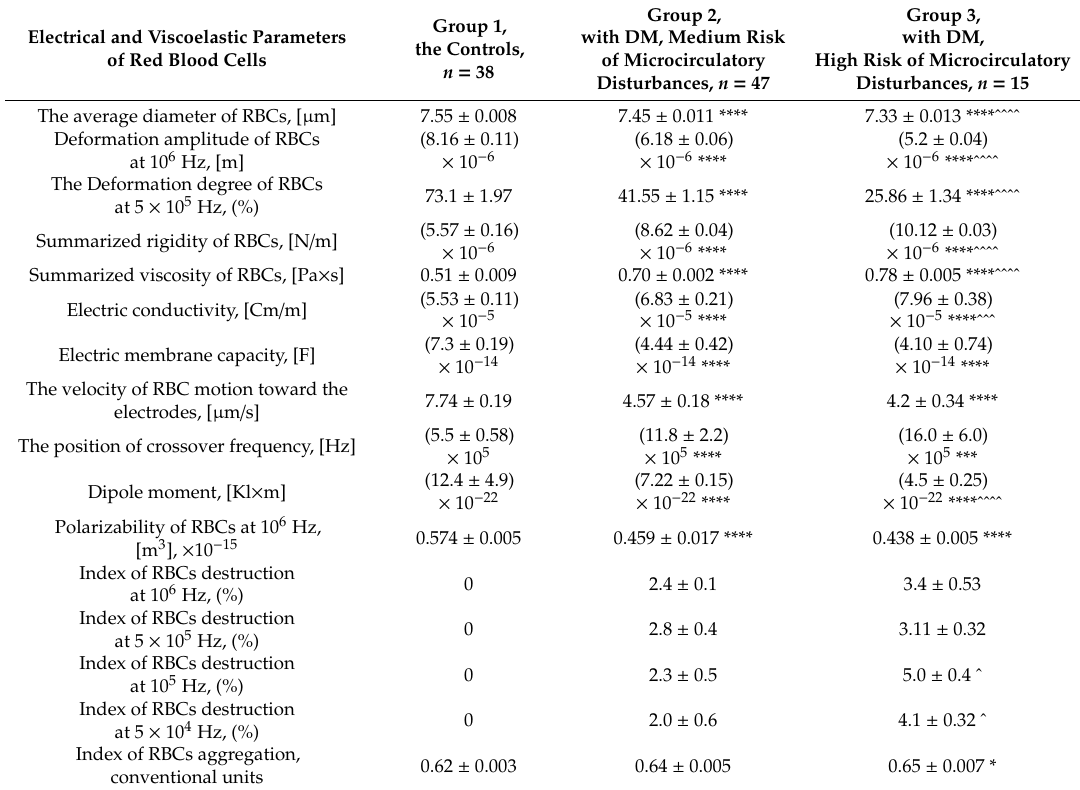
Table 2. Electrical and viscoelastic parameters of red blood cells in patients with diabetes with di ff erent degrees of microcirculatory disturbances (M ±